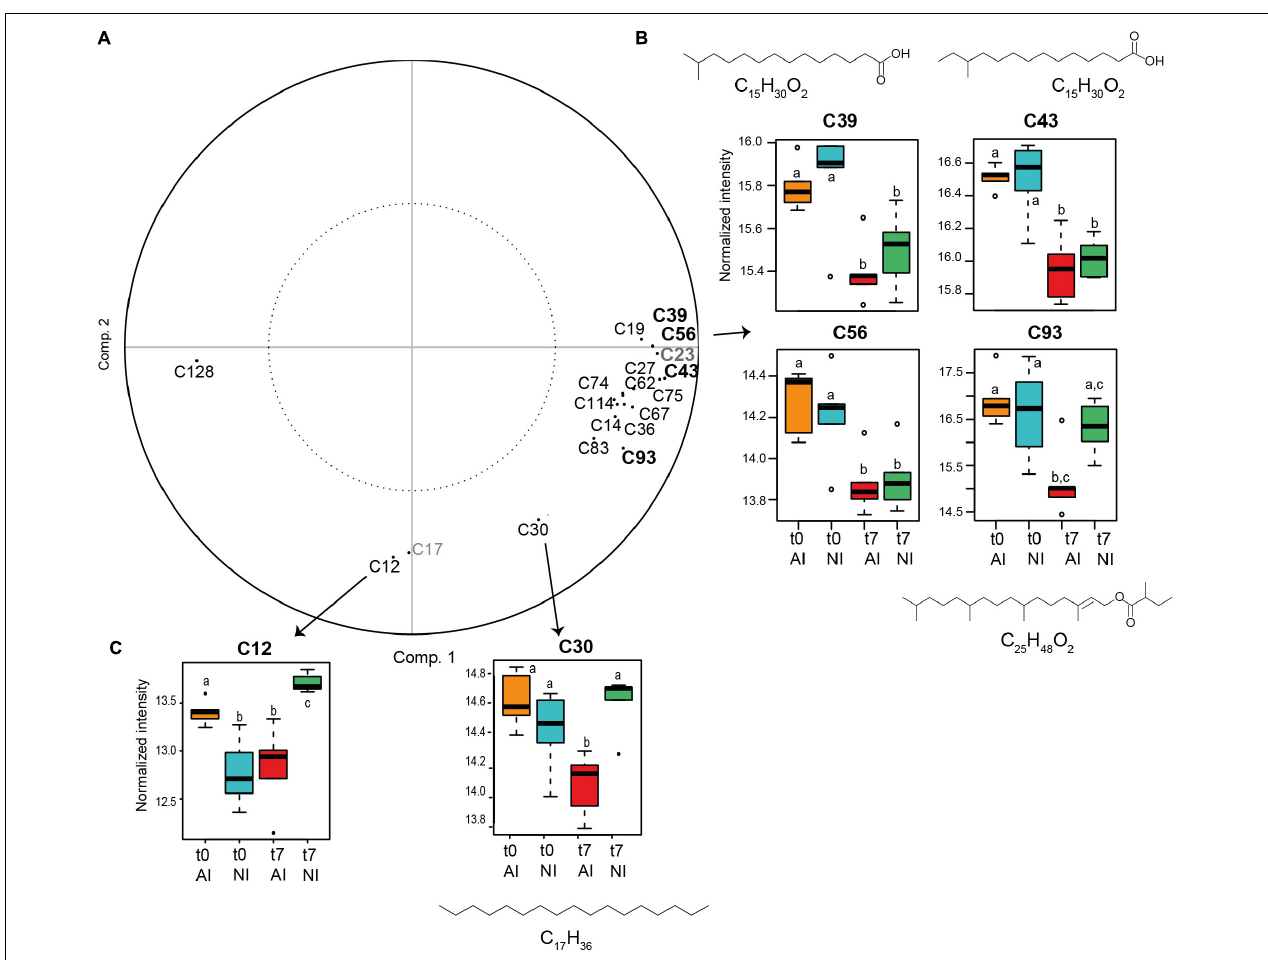
FIGURE 5 | (A) PPLS-DA loading in the CHCl 3 fraction (compounds in bold were selected with threshold = 0.8 and the others with threshold = 0.7. The two compounds in gray are plastic pollutants and were not considered). (B) Box plots of the compounds annotated in the CHCl 3 fraction responsible for metabolomic differences according to time (threshold = 0.8) and (C) to the light exposure condition at t7 (threshold = 0.7) (t0: beginning and t7: end of the experiment; NI: natural irradiance; AI: higher artificial irradiance). Ion intensities of metabolites are expressed as mean normalized intensities ± SD (log-transformed data, n = 5 per group). Statistical analyses were performed using Wilcoxon signed-rank tests to compare t0 vs. t7 samples and Mann–Whitney–Wilcoxon tests to compare light treatments. Letters indicate distinct groupings based on these tests for each compounds ( p < 0.05). Chemical formulas are displayed for annotated